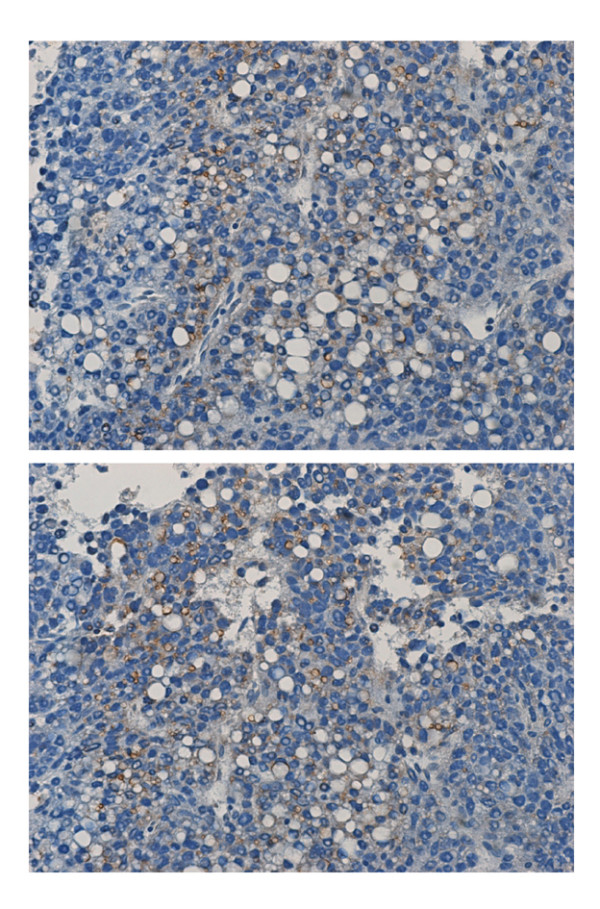
Immunohistochemistry analysis of CD133 expression in HCC in patient-16. Original magnification, 200×.